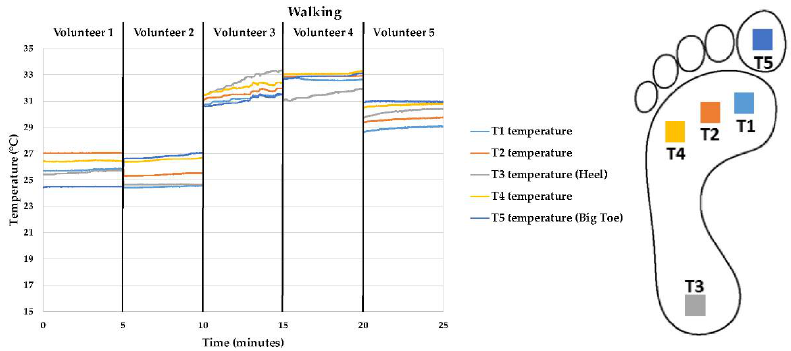
Figure 11. Temperature measurement from the temperature sensing sock when the sock worn under a shoe while walking for all the volunteers.